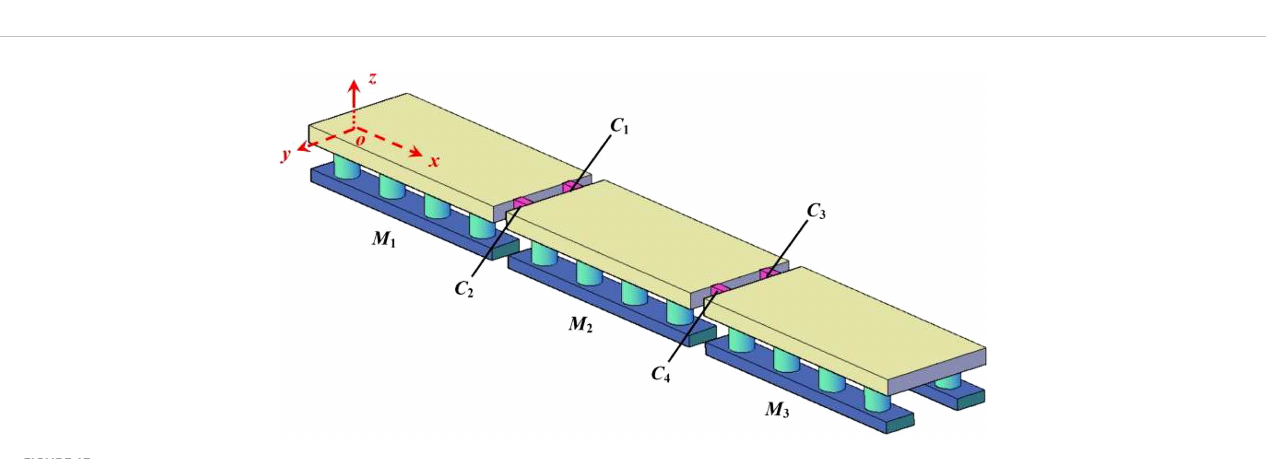
CA B FIGURE 12 Conceptual design of CP-VLFS module and the connectors ’ installation sites (units: m): (A) ox ’ z ’ plane; (B) oy ’ z ’ plane; (C) ox ’ y ’ FIGURE 13 Numerical model of CP-VLFS with three-modules and four-connectors.